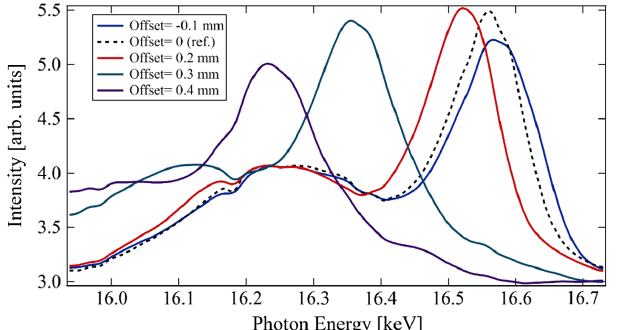
FIG. 23. Spectra measured (uncalibrated energy mono- chromator) on the NANOSCOPIUM beam line through a window aperture of 0 . 2 mm × 0 . 8 mm placed at a distance of 77 m from the undulator with electron beam parameters shown in Table II, but with current I ¼ 17 mA, β α